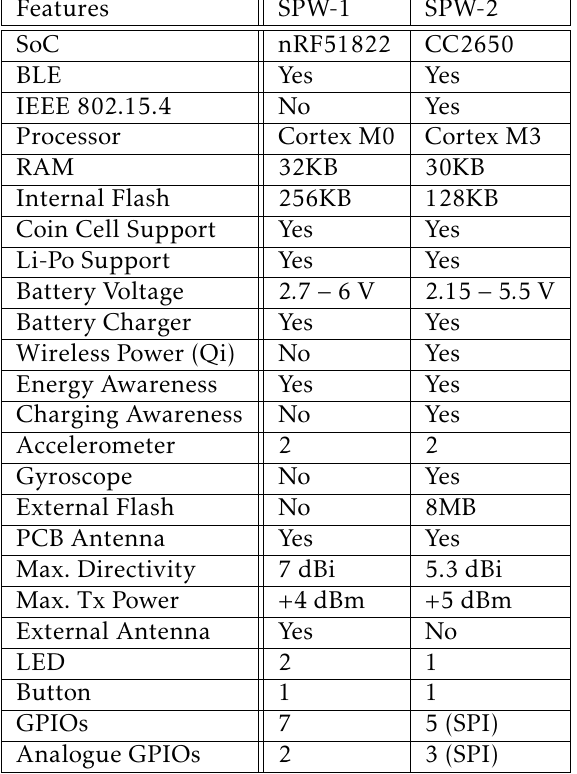
Table 1. Summary of